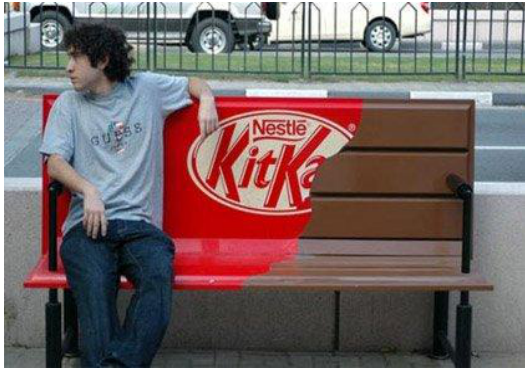
Figure 7. KitKat Chocolate Source: